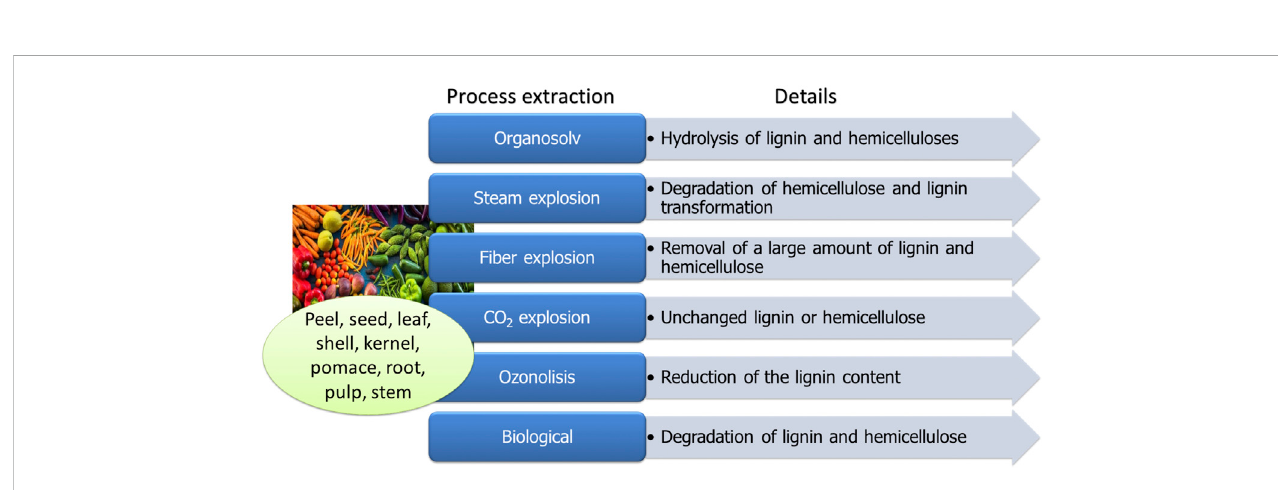
FIGURE 2 Illustrative processes for extracting substrates for biopolymer synthesis from food industry waste.